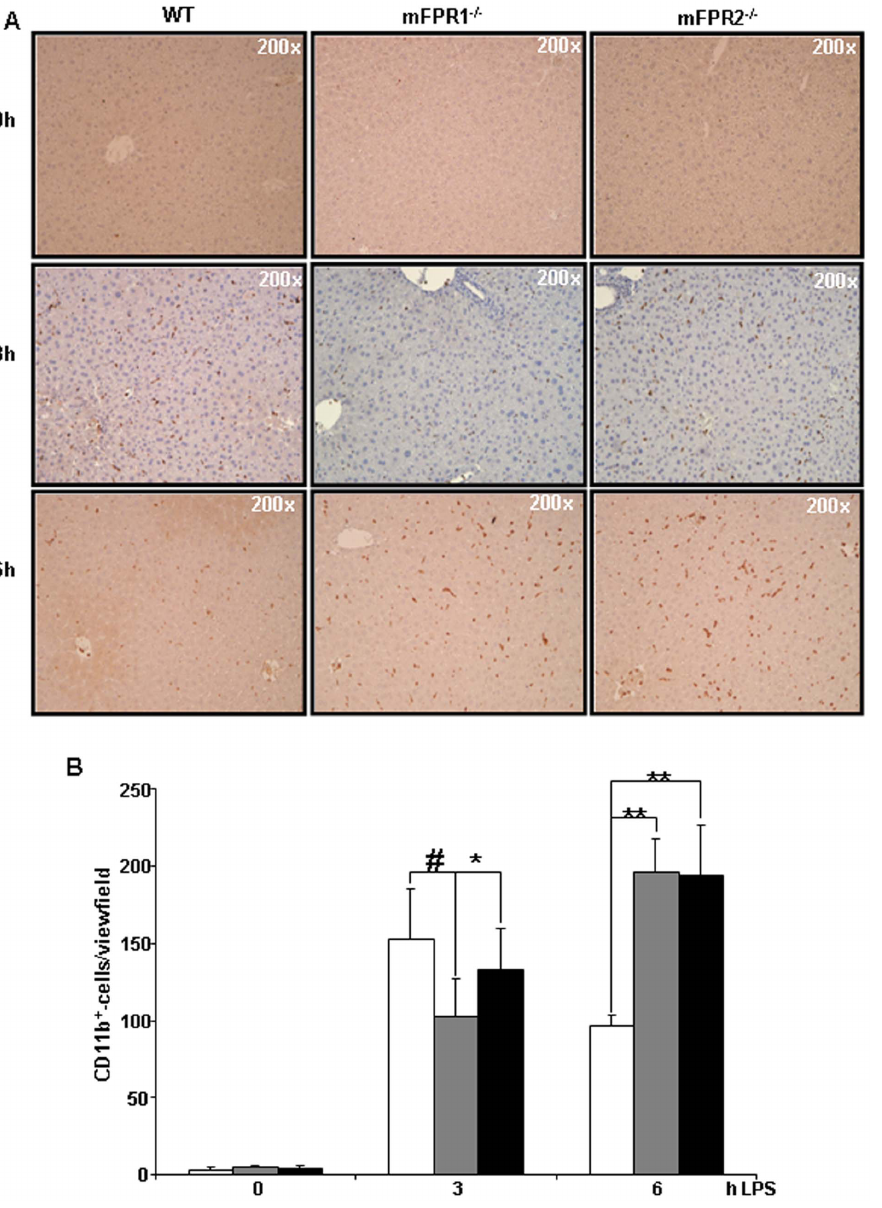
Figure 2. To identify the infiltrating immune cells after LPS stimulation according to their surface markers, CD11b was used to detect infiltrating monocytes and macrophages in the liver (A). Pictures were taken in 200-fold magnification and the CD11b + -cells were counted. The results were displayed as a graph (B) indicating differences among WT, mFPR1 -/- and mFPR2 -/- (*=p , 0.05; **=p , 0.01; # =p , 0.0001).